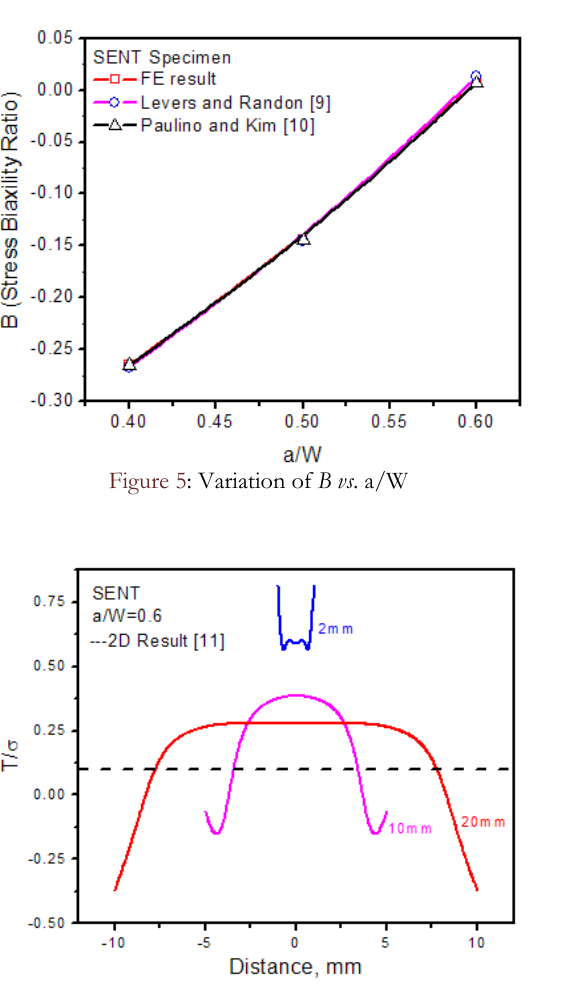
Figure 7: Variation of normalized T-stress along the crack-front Figure 8: Variation of normalized T-stress along the crack-front for various specimen thicknesses. for various a/W ratio and specimen thickness 10